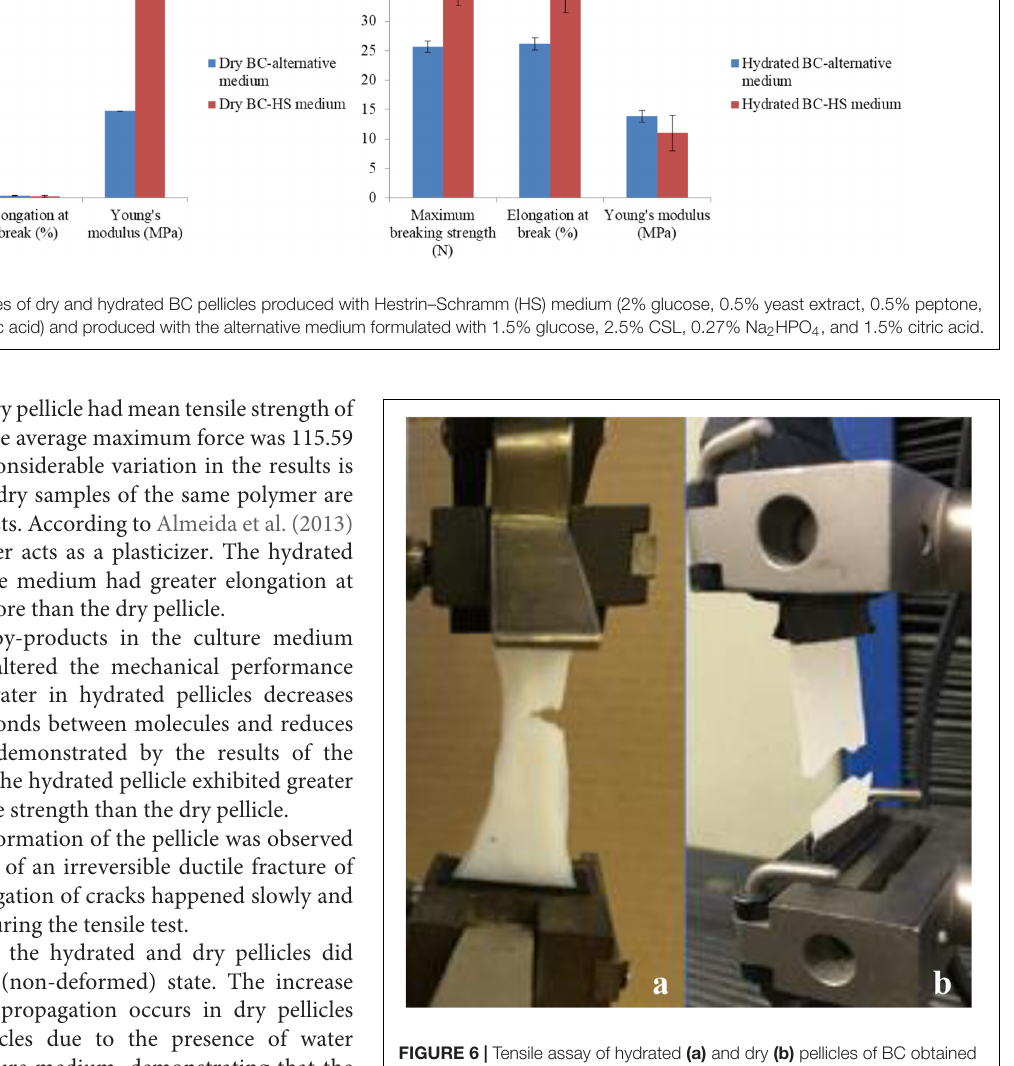
FIGURE 6 | Tensile assay of hydrated (a) and dry (b) pellicles of BC obtained in alternative medium formulated with 1.5% glucose, 2.5% CSL, 0.27% Na 2 HPO 4 , and 1.5% citric acid until complete rupture of